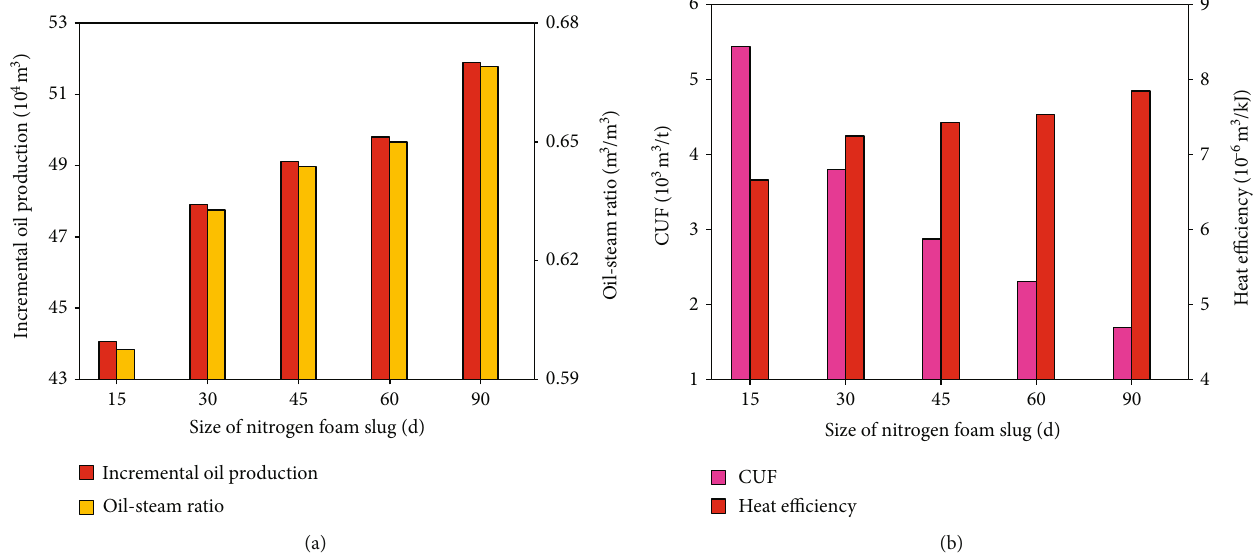
Figure 8: E ff ect of the size of nitrogen foam slug: (a) incremental oil production and oil-steam ratio; (b) CUF and heat e ffi